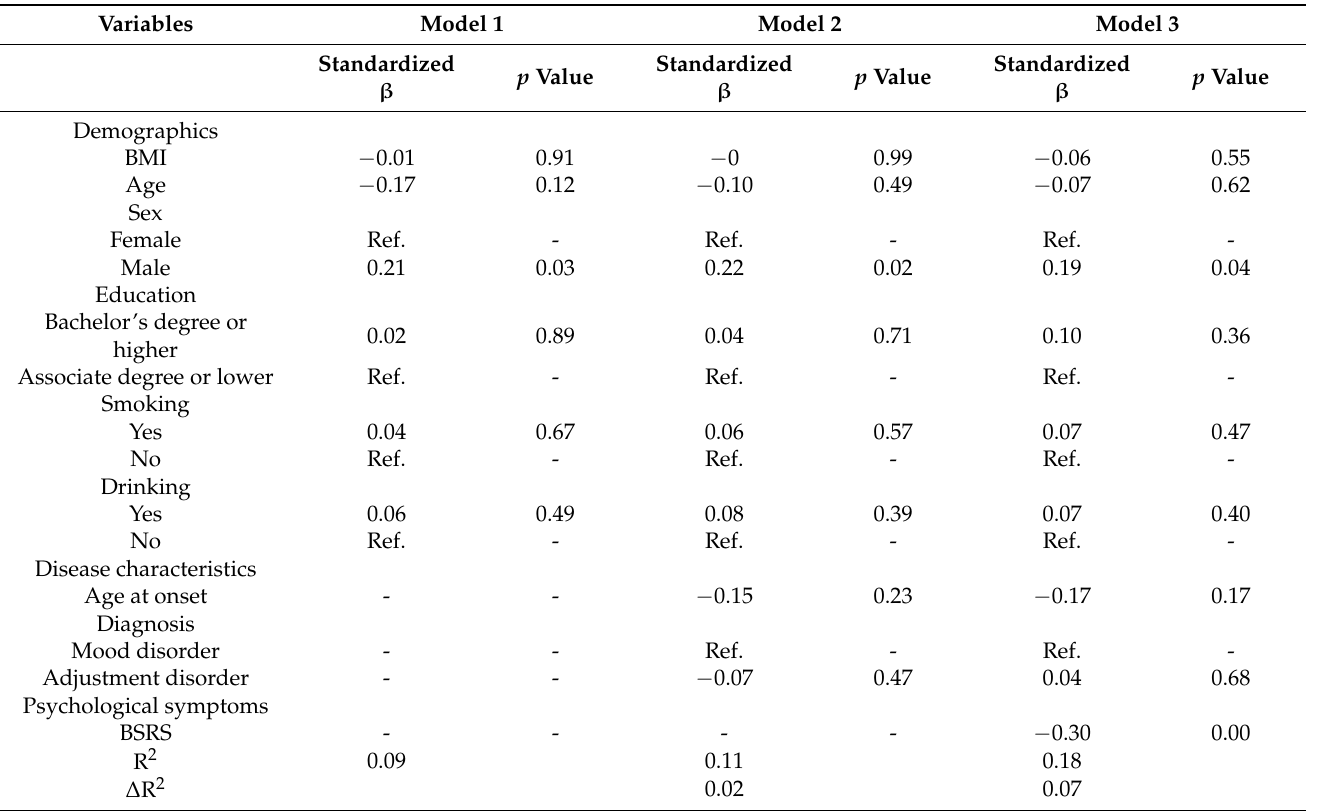
Table 3. Hierarchical linear regression model of quality of life ( n =